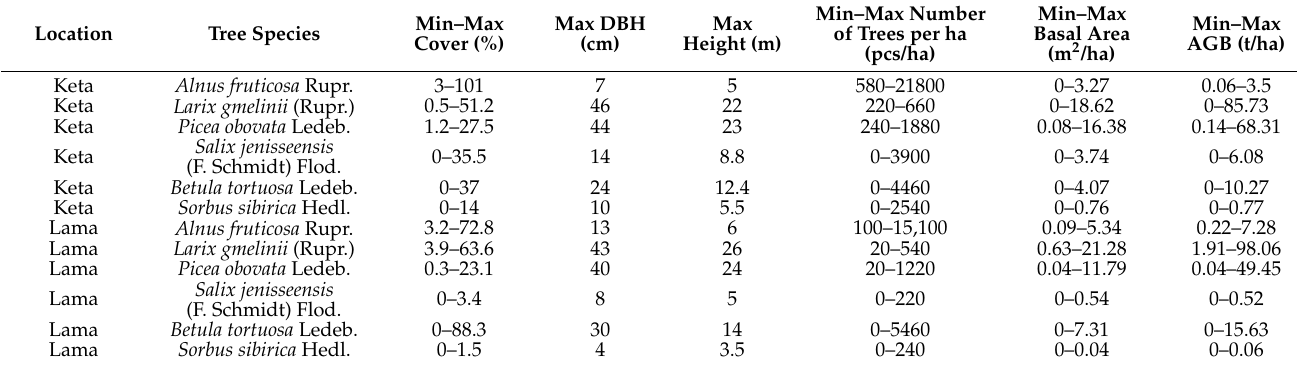
Table 7. Basic characteristics of tree